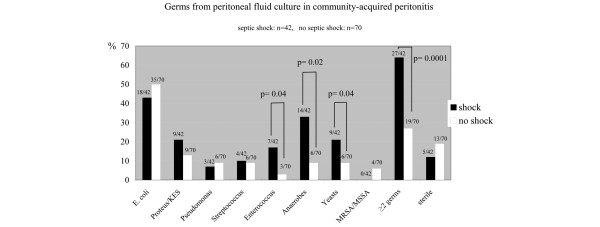
Proportion of microorganisma isolated from peritoneal fluid culture in community-acquired peritonitis with (black bars) or without (white bars) septic shock. On the top of each bar: number of patients in whom the microorganism was identified with respect to total number of patients in the subgroup (shock: n = 42; no shock: n = 70). KES = Klebsiella, Enterobacter, Serratia. MRSA/MSSA = methicillin-resistant Staphylococcus aureus/Methicillin-sensitive Staphylococcus aureus.